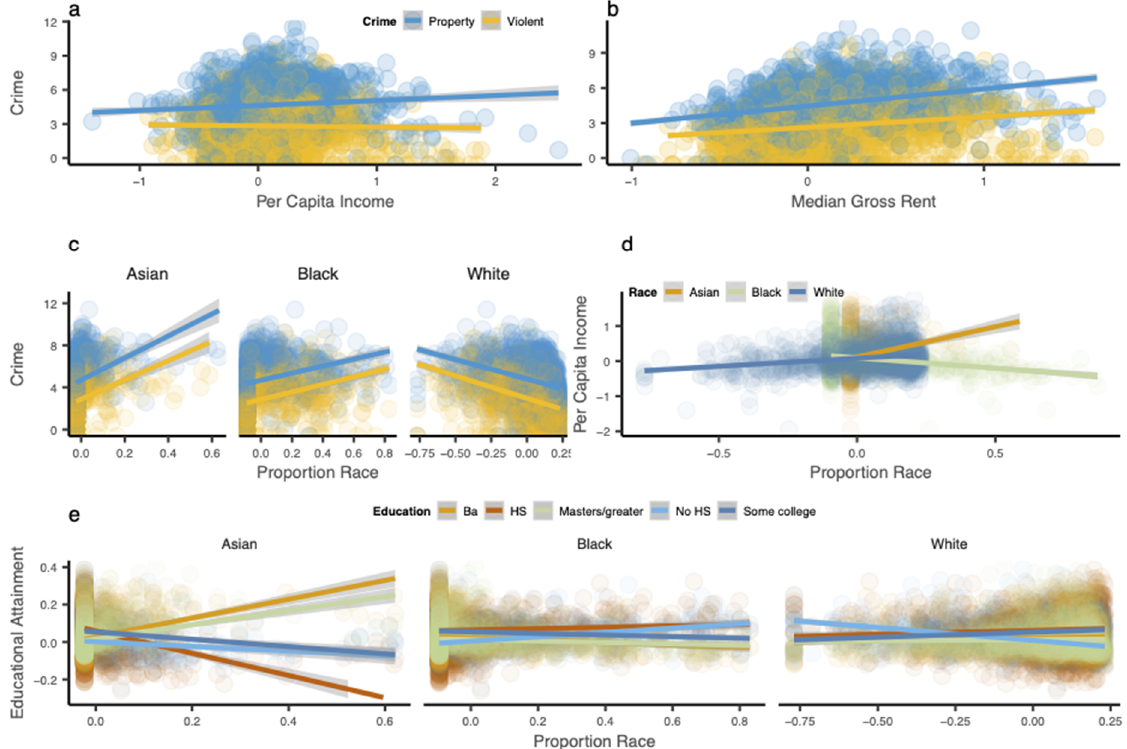
Figure 6. ( a – c ) plot the relationship between crime (violent and property) and covariates of per capita income, median rent cost, and race; ( d , e ) demonstrate the relationship of race as a function of per capita income and then as a function of educational attainment. Both per capita income and median rent are logged. All covariates are centered.